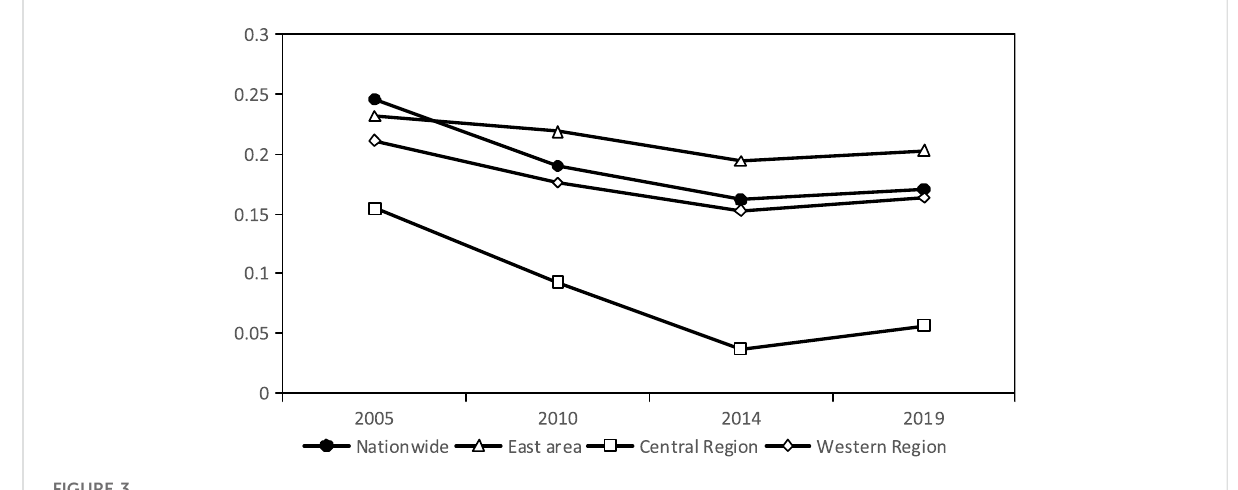
FIGURE 3 Convergence analysis of the coupling coordination.